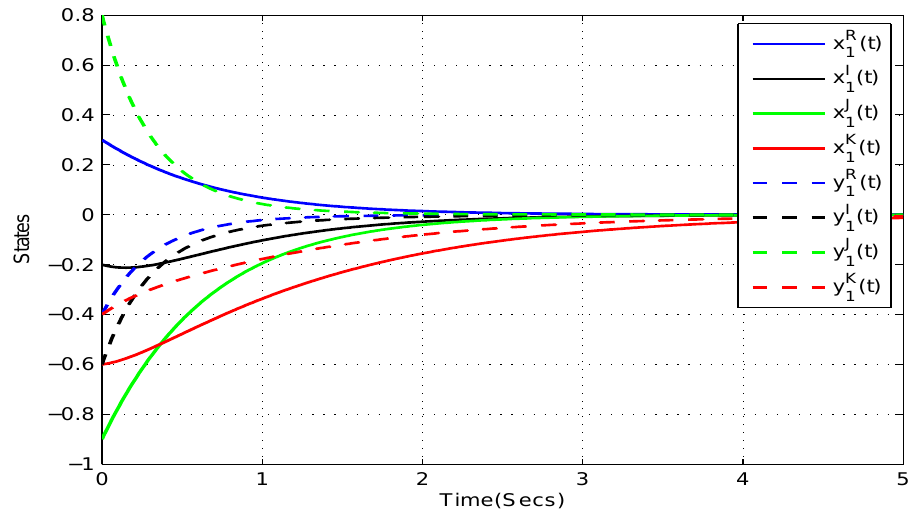
Figure 1. An illustration of the time responses with respect to the real-imaginary parts pertaining to the ( t ) , y K ( t ) in Example 1. ( t ) , x K ( t ) , y R ( t ) , y I ( t ) , y J ( t ) , x I ( t ) , x J states of x R 1 1 1 1 1 1 1 1